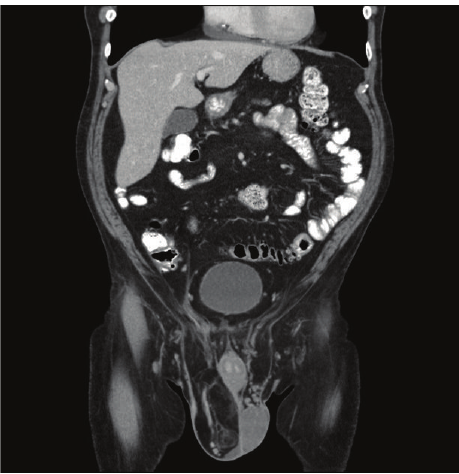
Figure 1: CT abdomen/pelvis read as a large fat-containing inguinal hernia present on the right side extending into the scrotal sac. No bowel loops are contained but there is a significant amount of omentum and fat present.